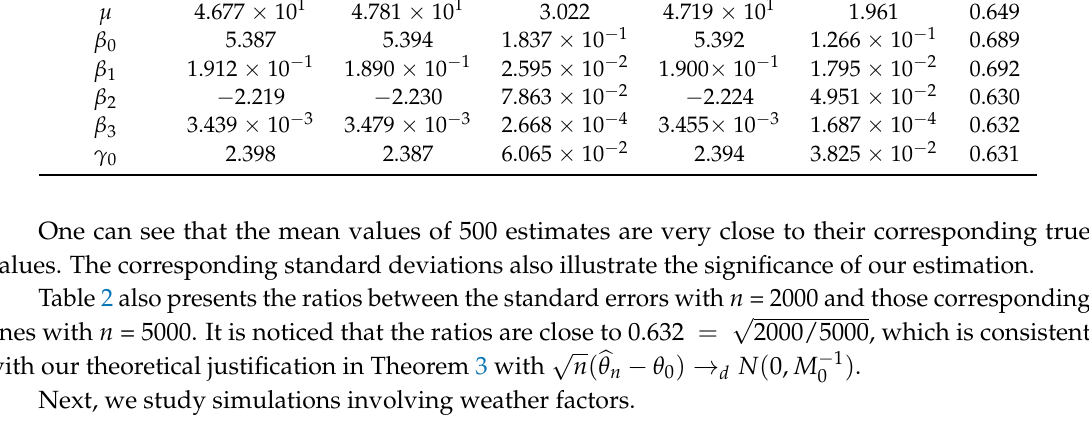
Table 2. Performance of MLE with the sample sizes of 2000 (SC1) and 5000 (SC2). Mean and SD are samples’ means and standard derivations of 500 estimated corresponding parameter values respectively. Ratio denotes the ratio between the standard errors with n = 2000 and standard errors with n = 5000.